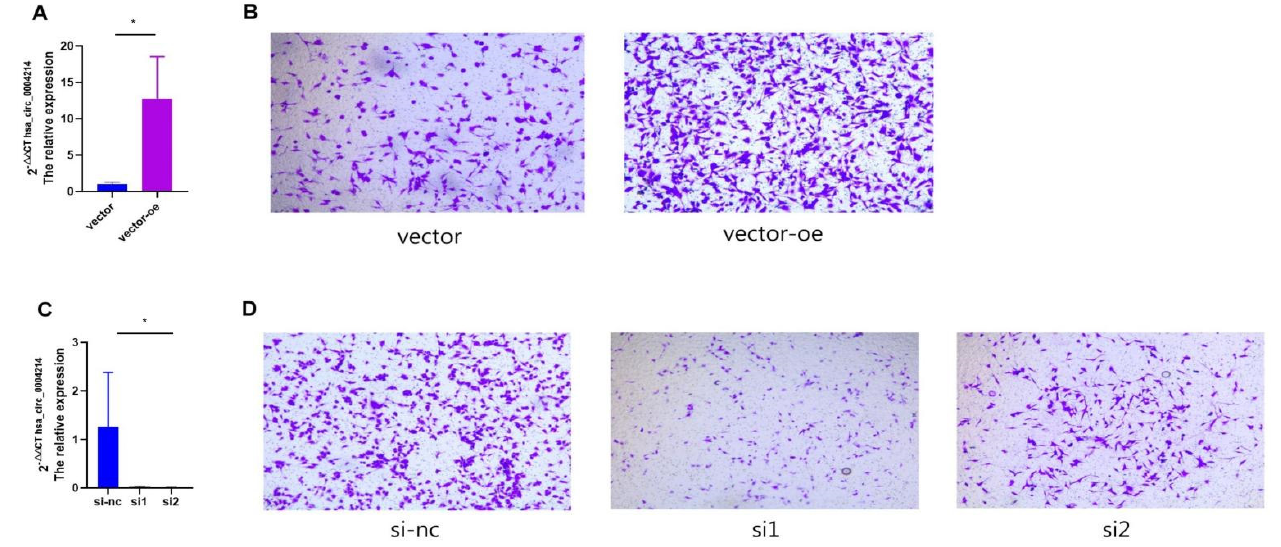
Figure 4. Judging the change of glioma cell migration capacity by changing the expression level of hsa_circ_0004214 in U87. ( A ) U87 cells transfected with hsa_circ_0004214 overexpression plasmid for 48 h, and the level of hsa_circ_0004214 was detected by RT-qPCR (* p < 0.05). ( B ) Transwell assay detected the migratory capacities of U87 cells after up-regulated the level of hsa_circ_0004214. Scale bar, 100 µ m (* p < 0.05). ( C ) U87 cells transfected with two siRNAs specifically targeting hsa_circ_0004214(si1, si2) for 48 h, and the level of hsa_circ_0004214 was detected by RT-qPCR. ( D ) Transwell assay detected the migratory capacities of U87 cells after down-regulated the level of hsa_circ_0004214. Scale bar, 100 μ m.